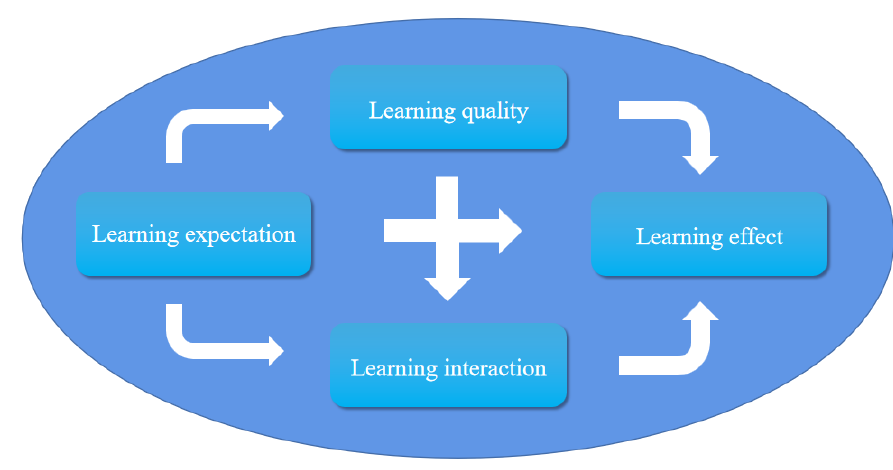
Figure 2. Theoretical model.